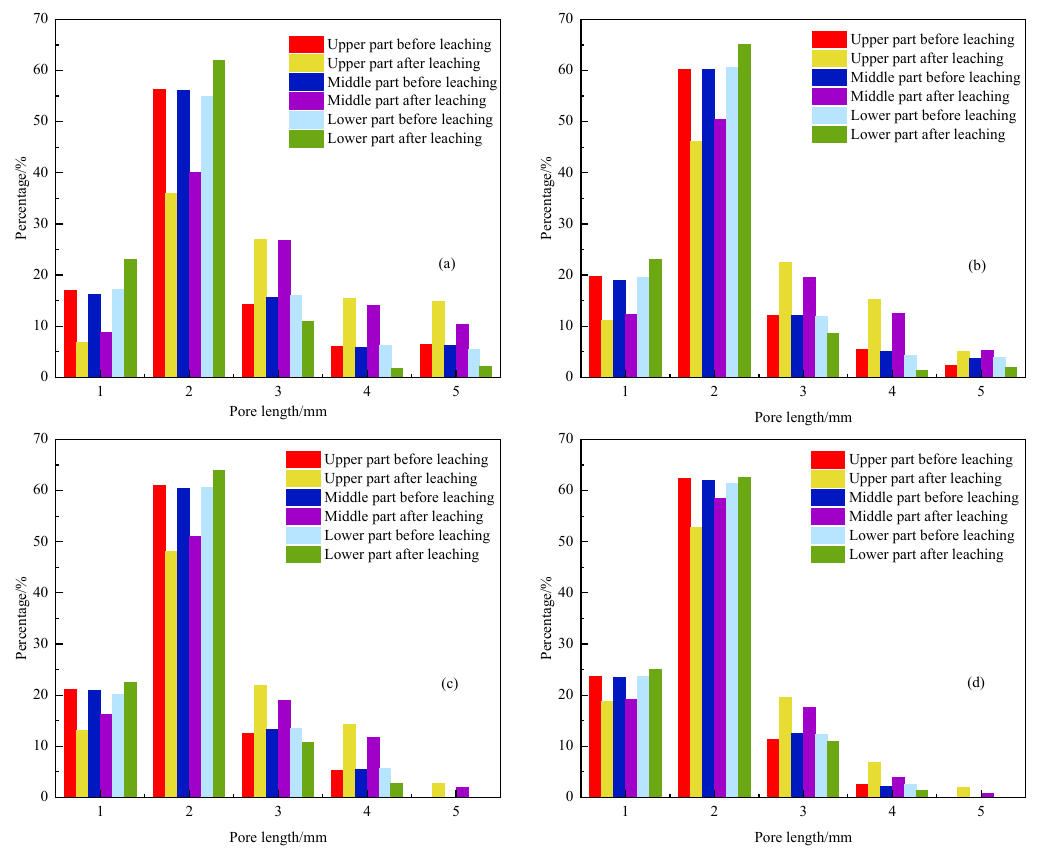
Figure 9. Variation rules of the pore length of four kinds of ore samples with different depths. ( a ) A D=2.03 ; ( b ) B D=2.23 ; ( c ) C D=2.43 ; ( d ) D D=2.63